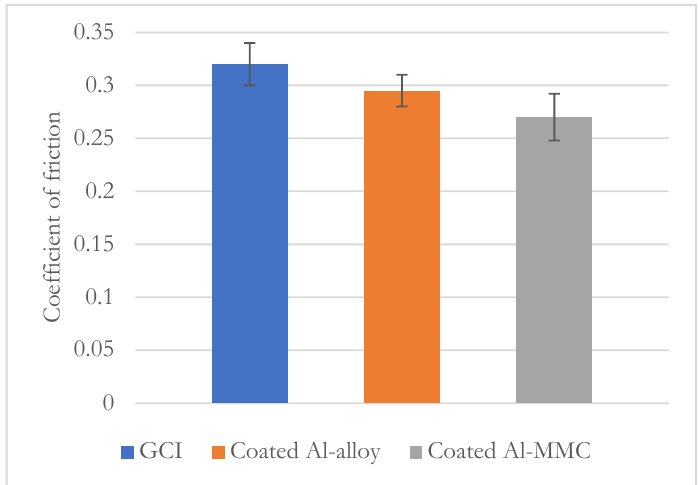
Figure 2. Average CoF for 3 different brake disc materials, adopted from Alnaqi et al. [49].